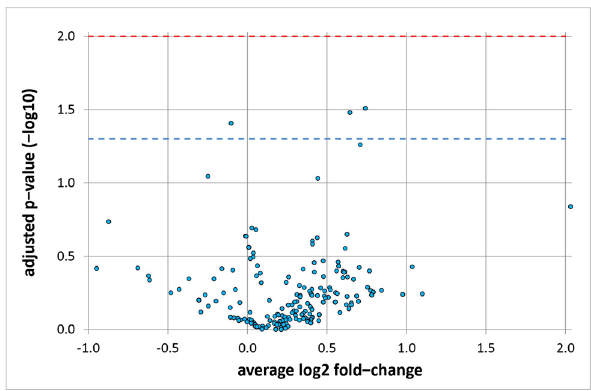
Figure 6: Volcano plot of di ff erentially expressed Reactome path - ways from TMD patient samples and a healthy control group, visualizing the fold - change ( x - axis ) and statistical signi fi cance ( y - axis ) . The red line corresponds to p = 0.05, and the blue line p =